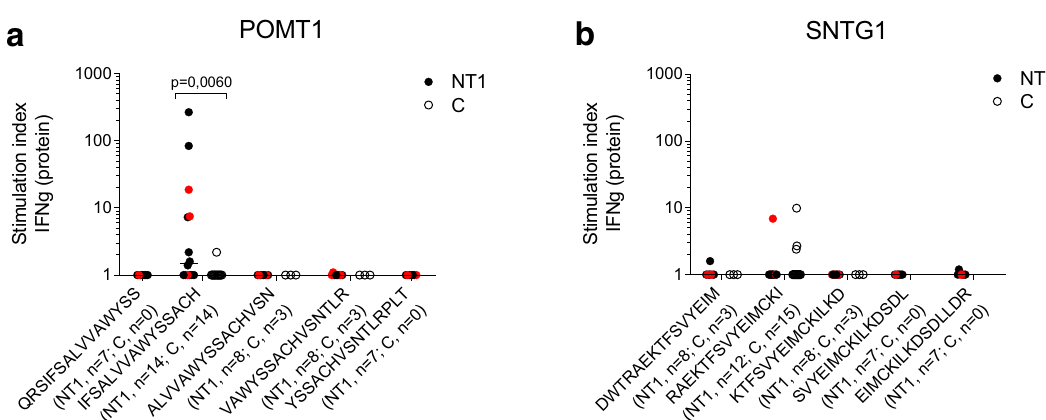
Fig. 5 Autoreactive T-cells in Pandemrix-associated NT1. a , b PBMC from pediatric Pandemrix-associated NT1 patients (NT1) or pediatric Pandemrix- vaccinated healthy controls (C) were stimulated in culture with overlapping 15-mer peptides derived from human protein-O-mannosyltransferase 1 (POMT1) or syntrophin gamma-1 (SNTG1), as indicated. The secretion of IFN- γ was measured by FMIA (protein). HLA-DQB1*0602 homozygous NT1 patients are marked with red dots. Results are expressed as the ratio between cytokine concentrations measured in peptide-stimulated and negative control samples (stimulation index). Statistical comparisons between groups were performed, using Kruskal – Wallis and Dunn ’ s multiple comparisons